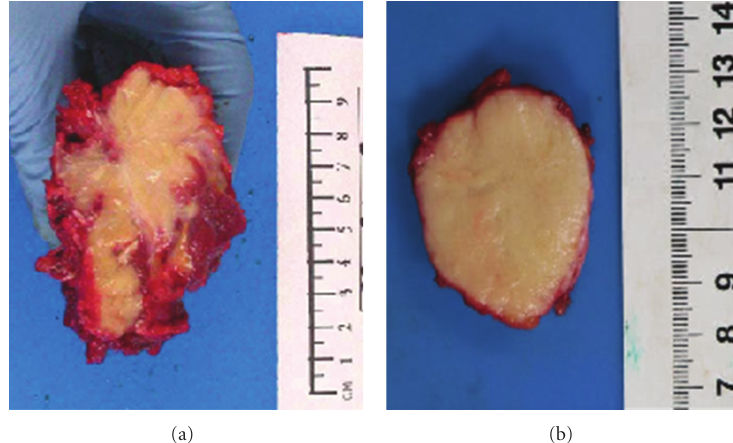
Figure 1: Gross appearance of granular cell tumour. This is an example of multicentric granular cell tumour (case number 10). On the left side (a), the tumour is poorly circumscribed solid and pale yellow, and shows infiltrative growth margin (paraspinal tumour). On the right side (b) the tumour shows better defined pushing margin (supraclavicular tumour).